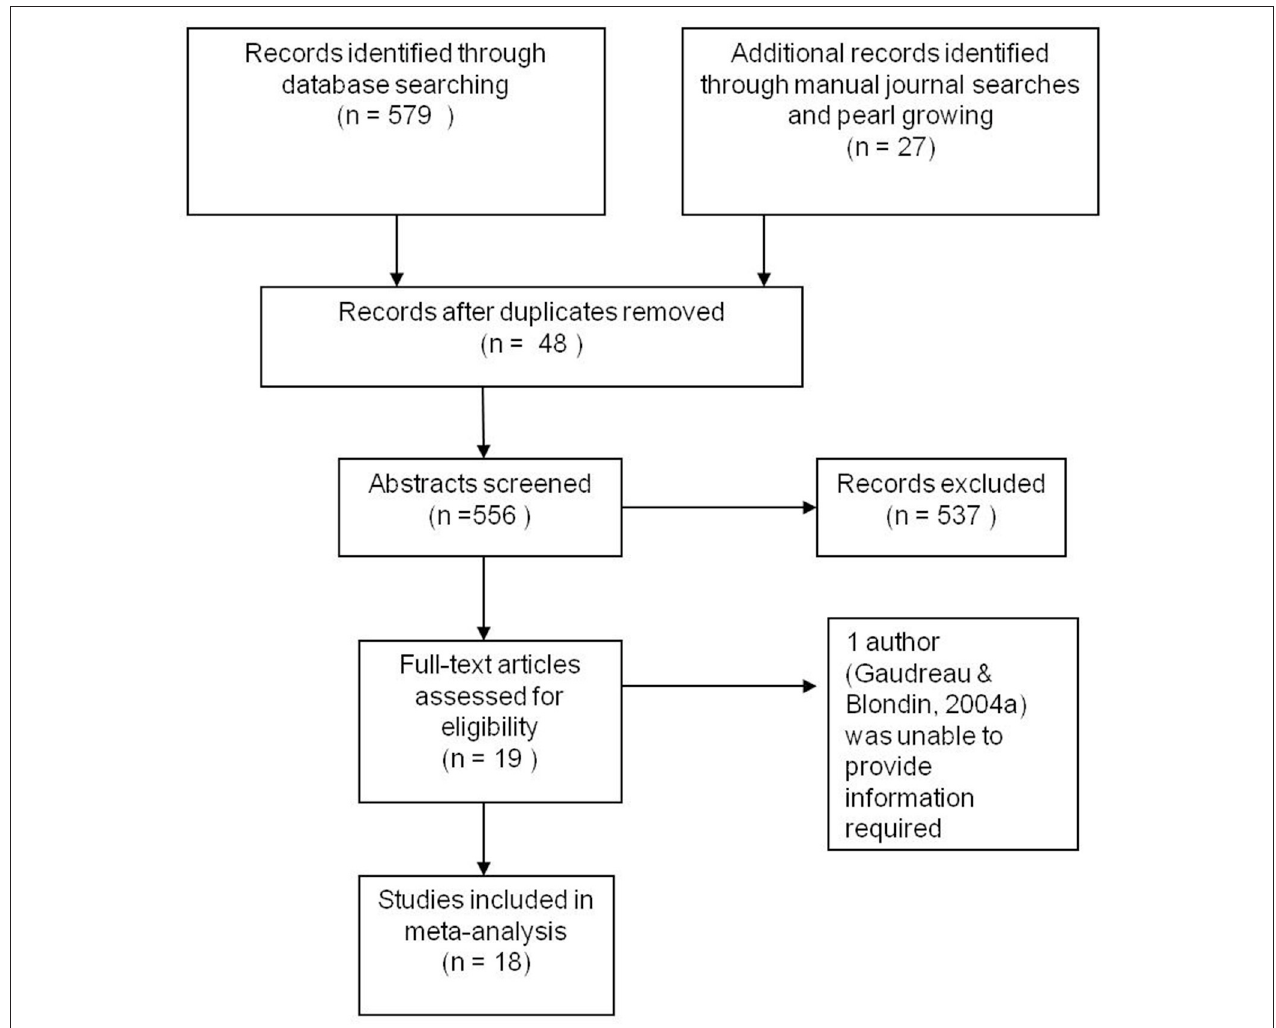
FIGURE 1 | PRISMA flow